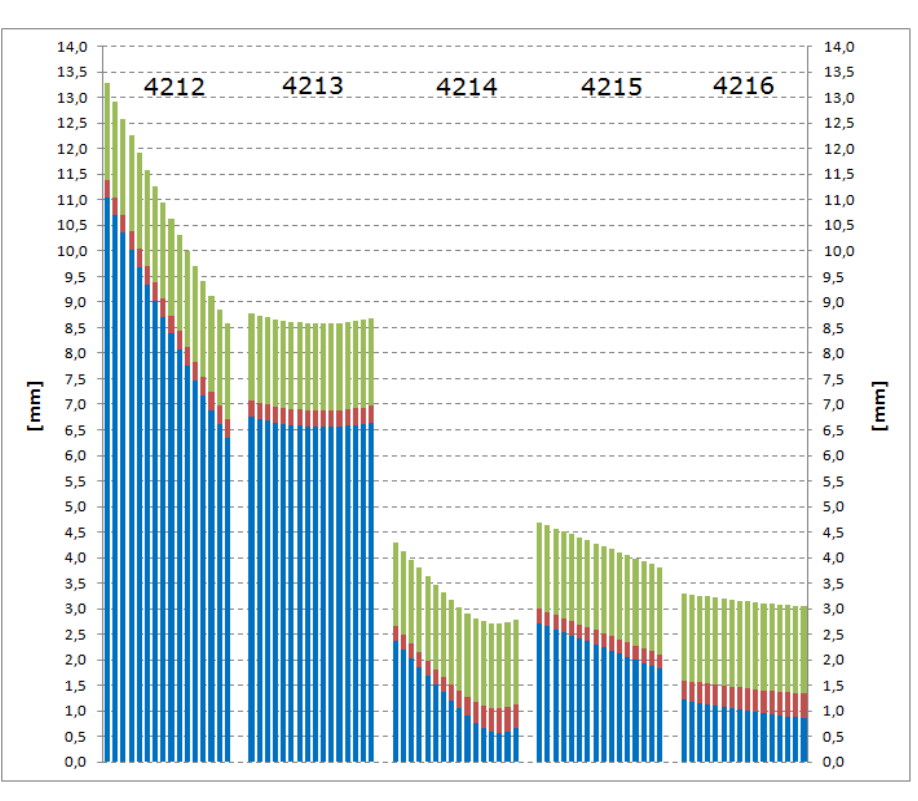
used for the calculation i and T standard i ,JUN i ,NOV to T = T go from left to right for each 0 P 15